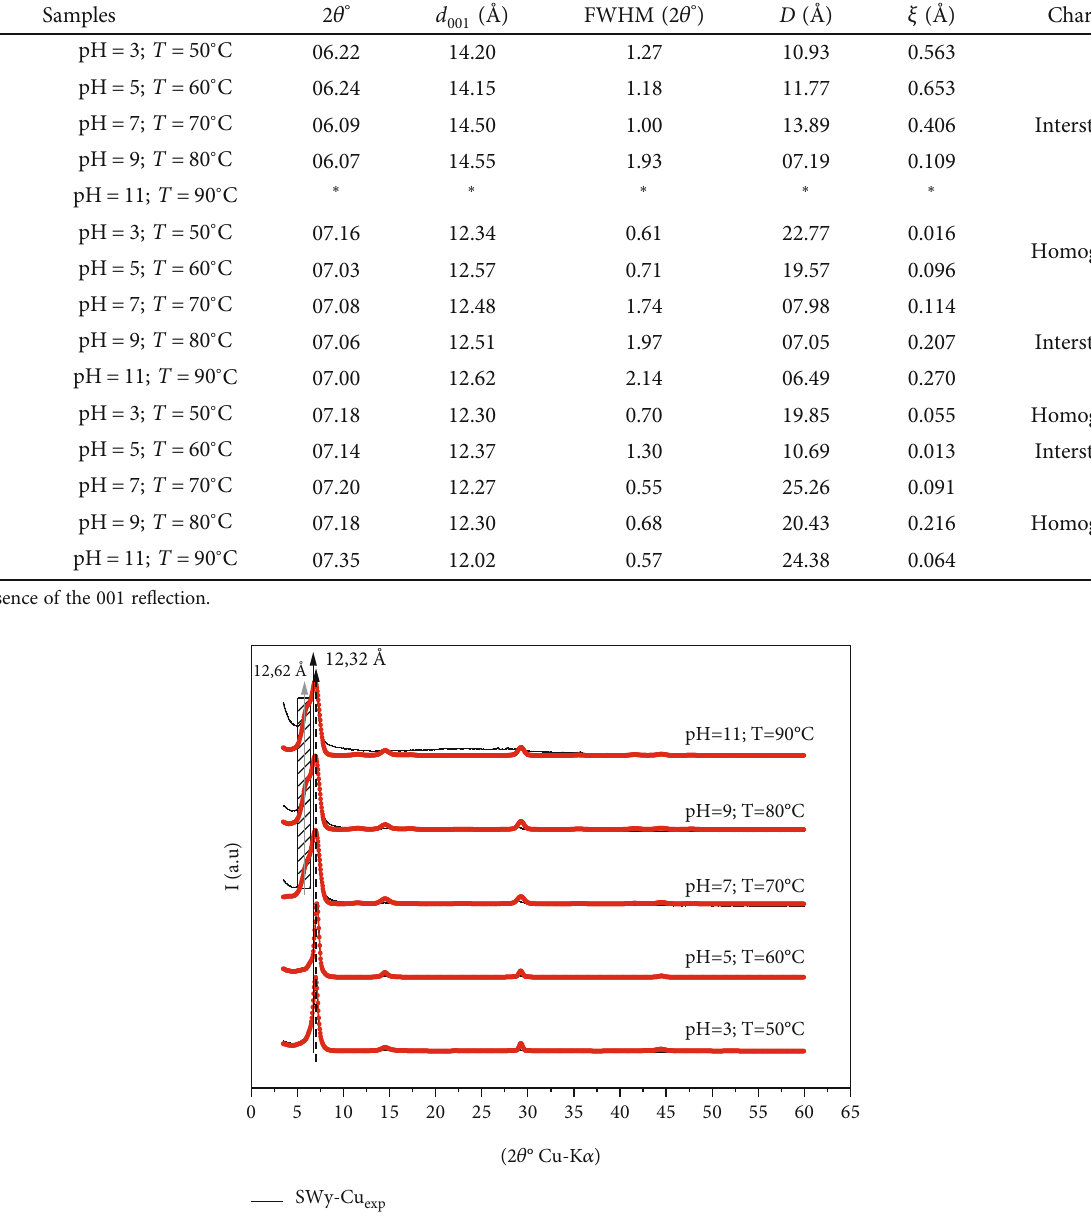
Table 6: Qualitative XRD investigation in the case of the samples SWy-Co SWy-Cu and SWy-Ba. Samples